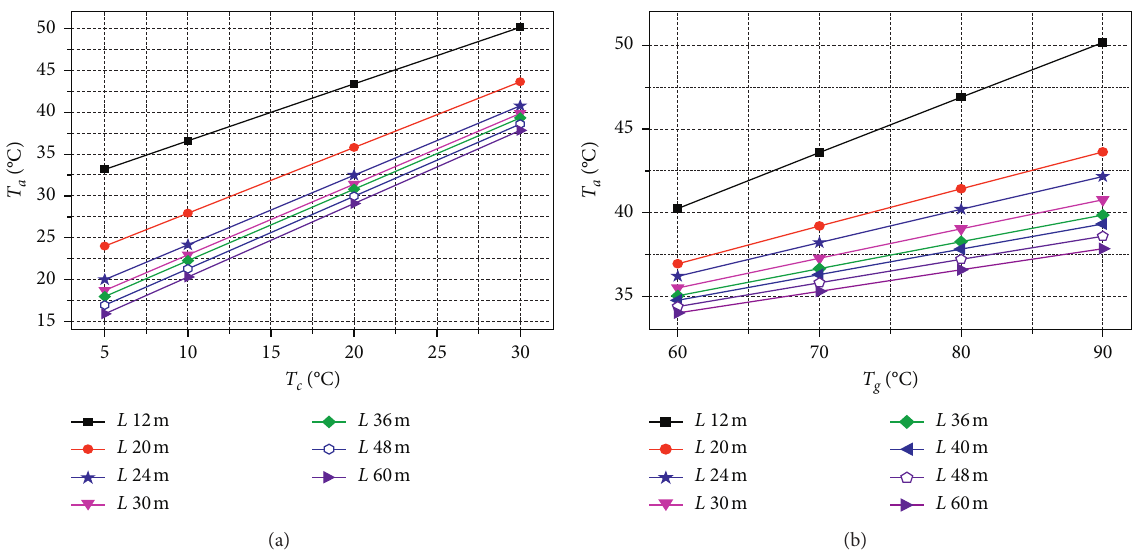
Figure 4: Influence of the chamber and surrounding rock temperature on the temperature gradient: temperature effect of T temperature effect of T g on T a (b).